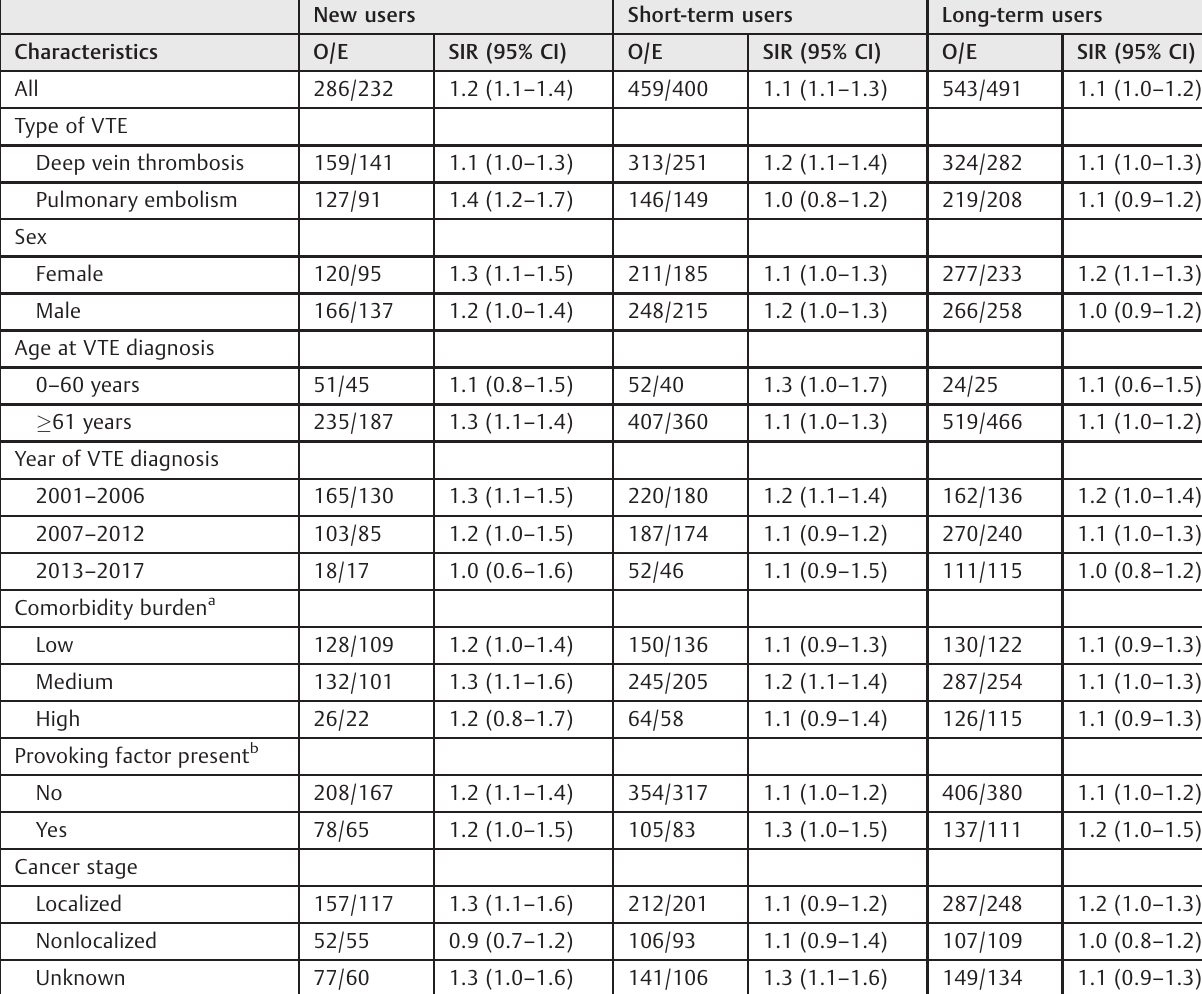
Table 5 Standardized incidence ratios for cancer in users of low-dose aspirin with venous thromboembolism during the second and subsequent years of